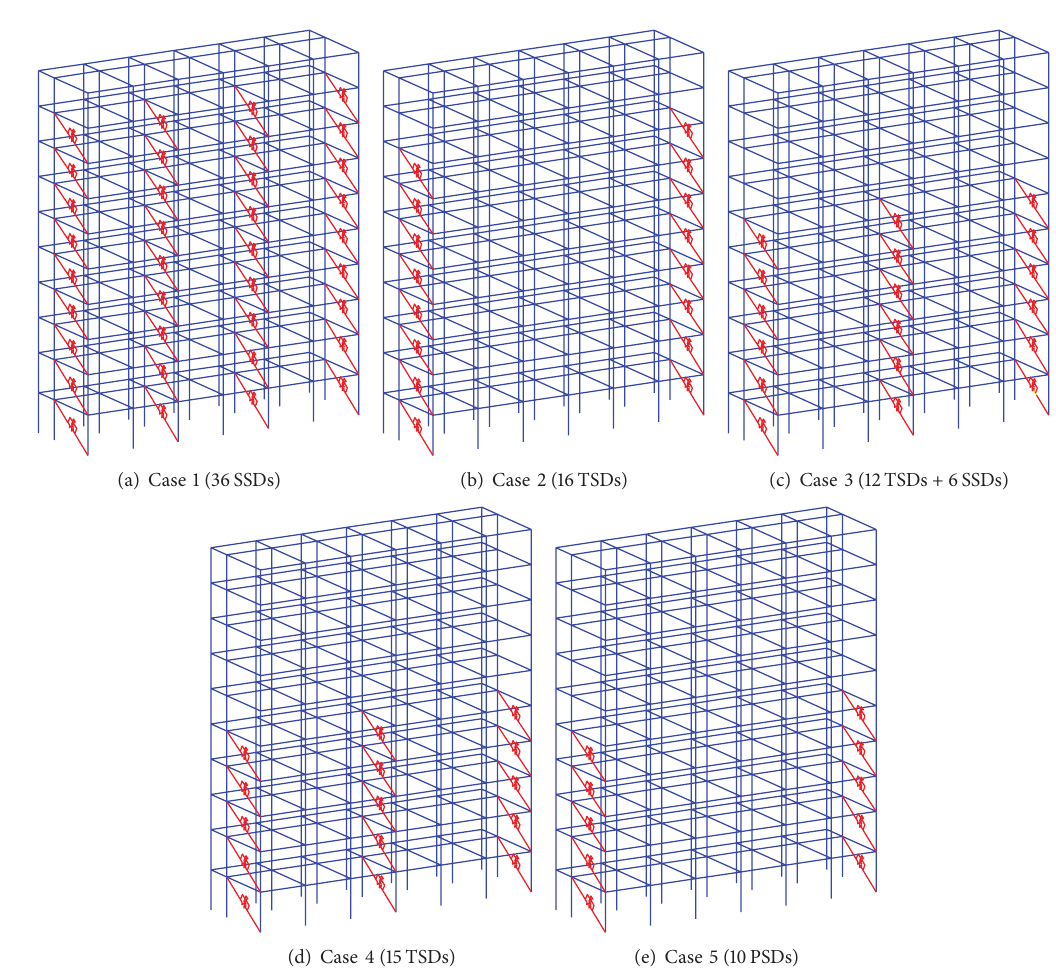
Figure 7: Various locations and combinations of the MSD